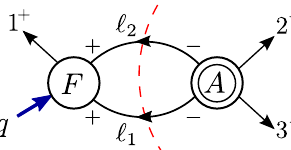
Figure 3 . A double cut of the two-loop minimal form factor of O S , O C : the case of a tree-level form factor joined to a one-loop